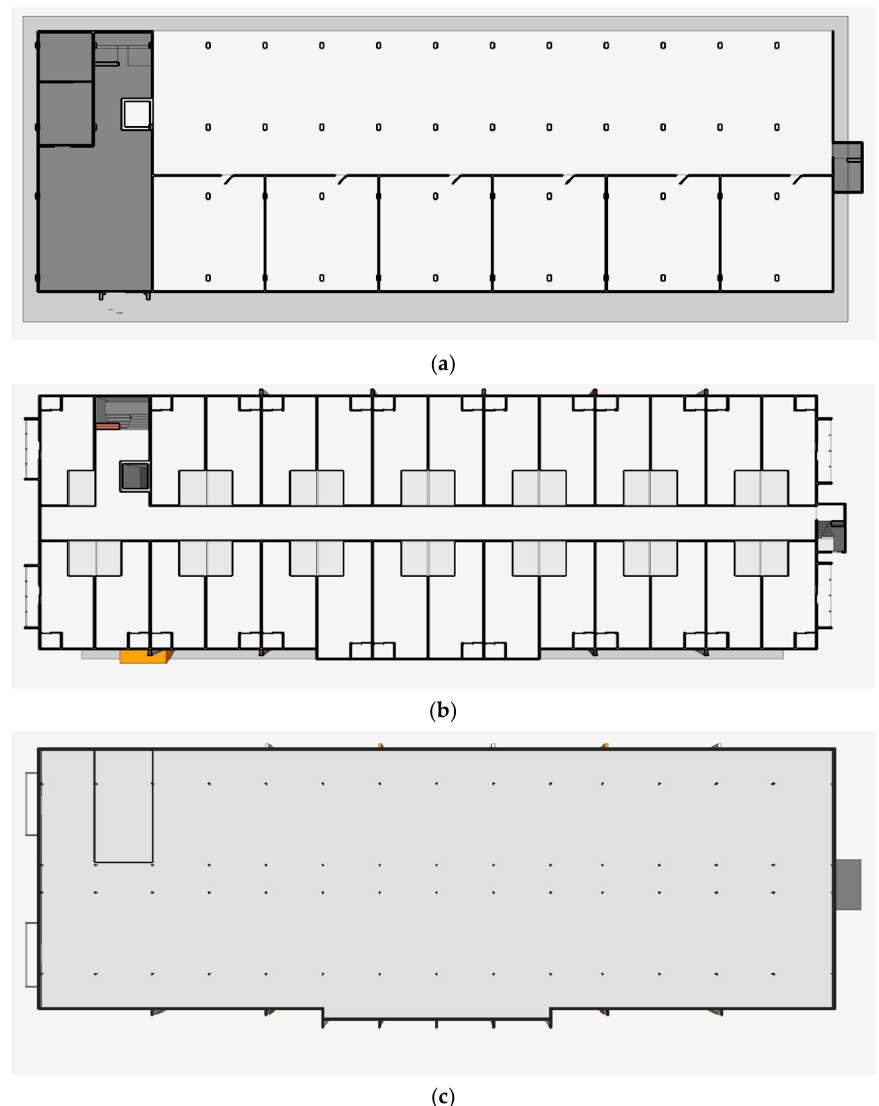
Figure 2. Floor plan of the case-study building: ( a ) First floor; ( b ) 2nd to 8th floor; ( c ) Rooftop.